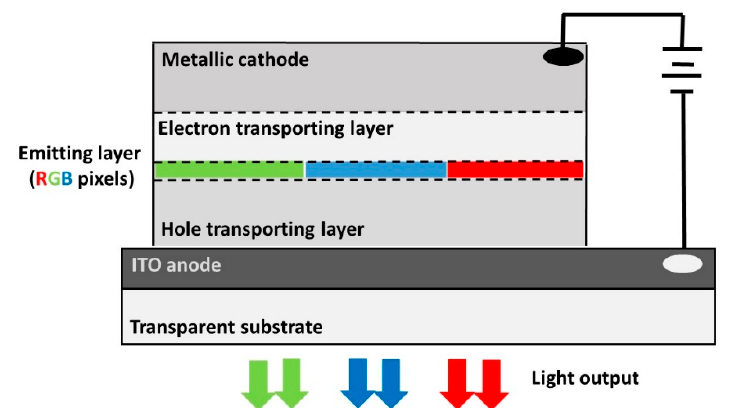
Figure 1. Sketch of the multi-layer architecture of a modern organic light-emitting diode (OLED) including a metallic cathode, a layer favoring the electron transport (thus blocking the hole transport), the emitting layer, a layer favoring the hole transport (thus blocking the electron transport), the indium tin oxide (ITO) anode, and the transparent substrate. In an OLED device, the light-emitting active molecules are excited after the electron–hole recombination (i.e., exciton formation) from the cathode and the anode, with associated light emission when returning to the ground state.